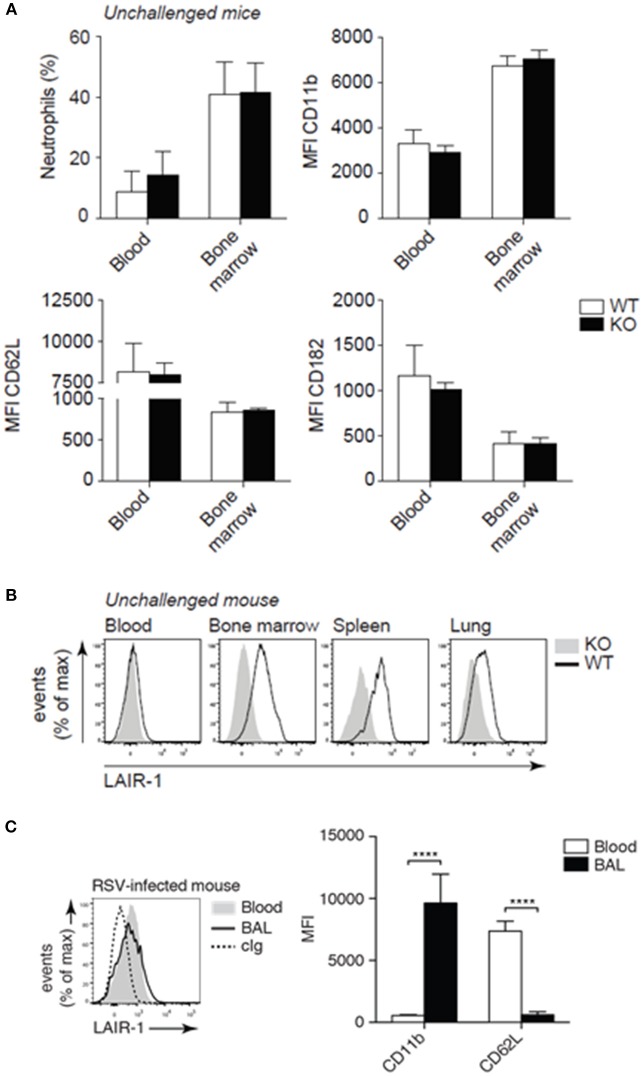
LAIR-1 expression and deficiency in mice. (A–C) Mouse leukocytes were examined for lineage and activation markers and LAIR-1 expression by flow cytometry. Neutrophils were identified based on characteristic forward- and side-light scatter properties and the expression of Ly-6G. (A) The percentage neutrophils (Ly-6G+) among total live leukocytes in blood and bone marrow as well as the expression of activation markers (CD11b, CD62L, and CD182) were compared by flow cytometry. (B) Flow cytometric analysis of LAIR-1 expression on blood and tissue (bone marrow, spleen, and lung) neutrophils. (C) Wild-type mice were inoculated with RSV and sacrificed 2 days post-infection. Expression of LAIR-1 and activation markers (CD11b and CD62L) was measured on BAL and blood neutrophils. ****p < 0.0001; 2-way ANOVA with Holm-Šídák multiple comparison correction. Data are representative of eight mice (A, B) or three independent experiments with at least three mice (C). Error bars in (A) and (C) represent mean ± SD. WT, wild-type and KO, Lair1−/− on C57BL/6 background; cIg, isotype-matched control antibody; MFI, mean fluorescence intensity.